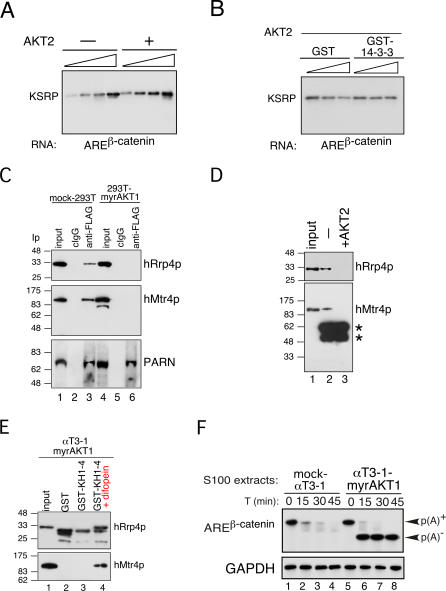
AKT Activation Affects KSRP-Exosome Interaction(A) The interaction between 32P-labeled ARE β-catenin RNA and recombinant purified KSRP (increasing amounts from 30 to 300 nM) subjected to kinase reactions in the absence or in the presence of AKT2 (as indicated) was evaluated by UV-crosslinking.(B) The interaction between 32P-labeled ARE β-catenin RNA and recombinant purified KSRP (50 nM) subjected to AKT2 phosphorylation in the presence of either GST (50 nM) or GST–14-3-3 (50 nM, as indicated) was evaluated by UV-crosslinking.(C) Coimmunoprecipitation of FLAG-KSRP and either endogenous exosome components (hRrp4p and hMtr4p, as indicated) or endogenous deadenylase PARN in 293T cells transiently transfected with FLAG-KSRP and either pCMV empty vector (mock-293T) or pCMV-myrAKT1 (293T-myrAKT1). Cell lysates were immunoprecipitated as indicated and analyzed by immunoblotting using the indicated antibodies.(D) GST pull-down of endogenous hRrp4p and hMtr4p from total extracts of αT3-1 cells using GST–KH1-4 subjected to kinase reaction either in the absence or in the presence of AKT2. Proteins were analyzed by immunoblotting using the indicated antibodies. Asterisks indicate antibody cross-reactivity with GST-fusion proteins.(E) GST pull-down of endogenous hRrp4p and hMtr4p from total extracts of αT3-1–myrAKT1 cells using either control GST, GST–KH1-4, or GST–KH1-4 preincubated with 50 nM difopein (as indicated). Proteins were analyzed by immunoblotting using either anti-hRrp4p or anti-hMtr4p antibodies.(F) In vitro RNA degradation assays using S100s from either mock αT3-1 or αT3-1–myrAKT1 cells. Internally 32P-labeled, capped, and polyadenylated β-catenin and GAPDH RNA substrates were incubated with S100s for the indicated times, and their decay was analyzed as described in Materials and Methods. Arrows point to either poly(A)+ or poly(A)− β-catenin RNA species.